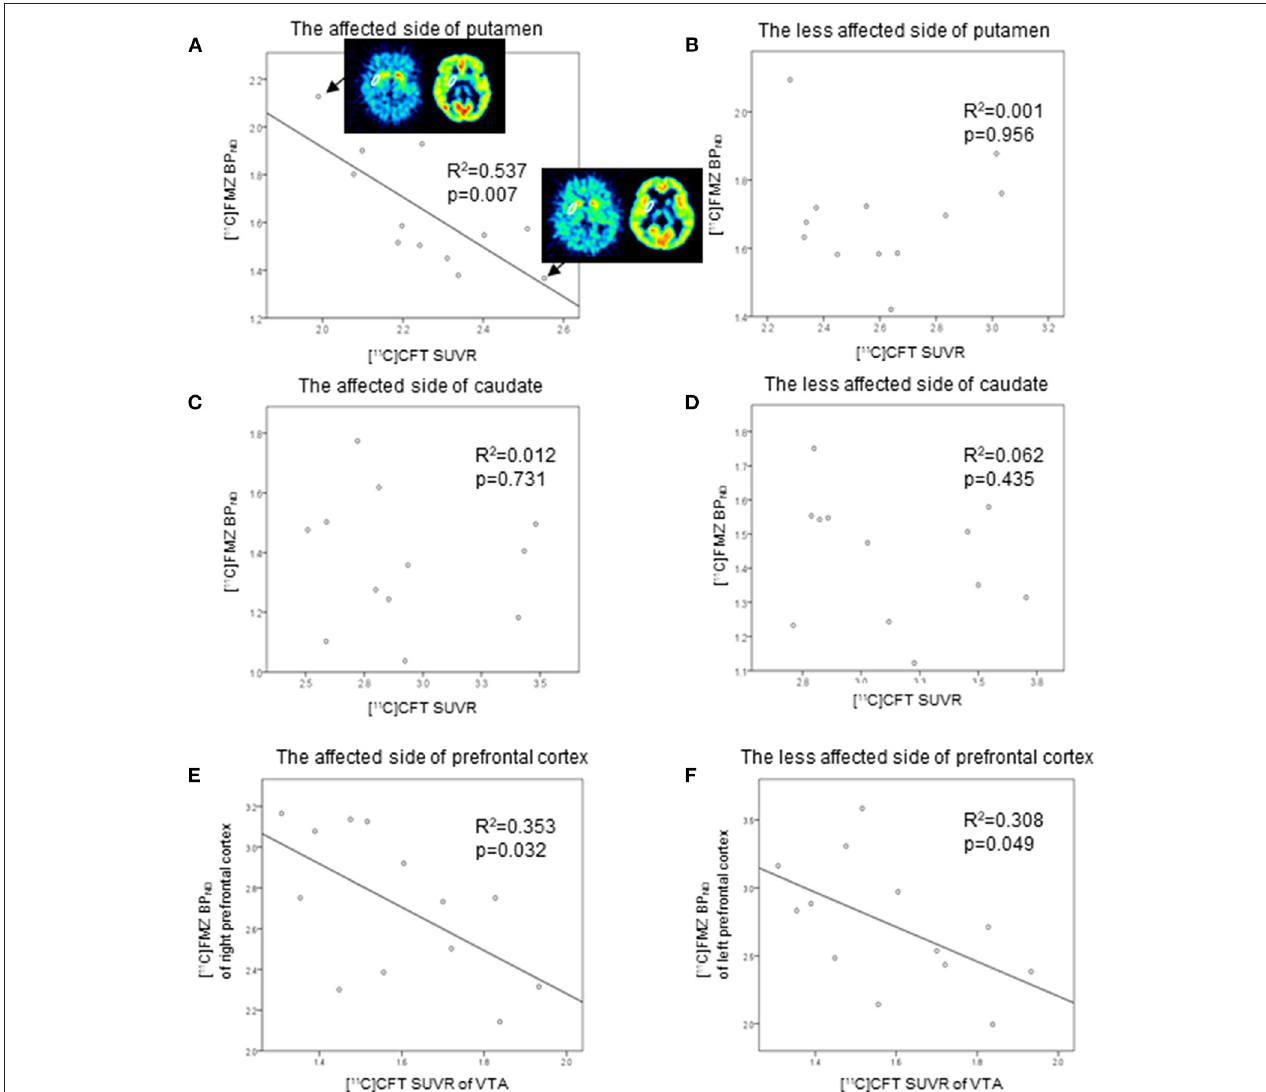
FIGURE 3 | Scatter plot of the [ 11 C]FMZ BP ND and [ 11 C]CFT standardized uptake value ratio (SUVR). The [ 11 C]FMZ BP ND was negatively correlated with [ 11 C]CFT SUVR on the more affected side of the putamen (A) (corrected p < 0.05). The [ 11 C]FMZ SUVR was not correlated with [ 11 C]CFT SUVR (B–D) on the less affected side of the putamen or bilateral caudate. [ 11 C]CFT SUVR in the VTA was tended to correlate negatively with [ 11 C]FMZ BP ND in the bilateral prefrontal cortical areas (E,F) (corrected p >